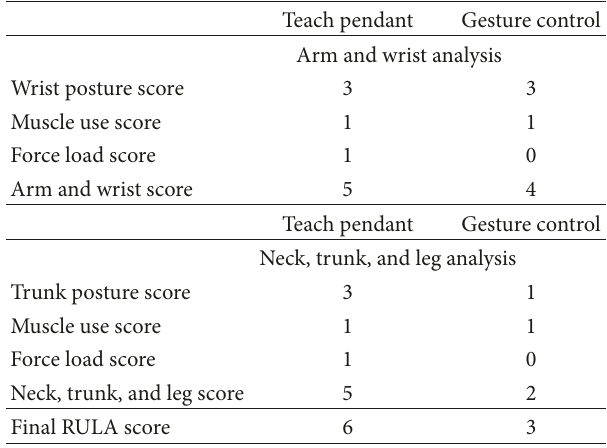
Table 2: RULA analysis scores for teach pendant and gesture con-